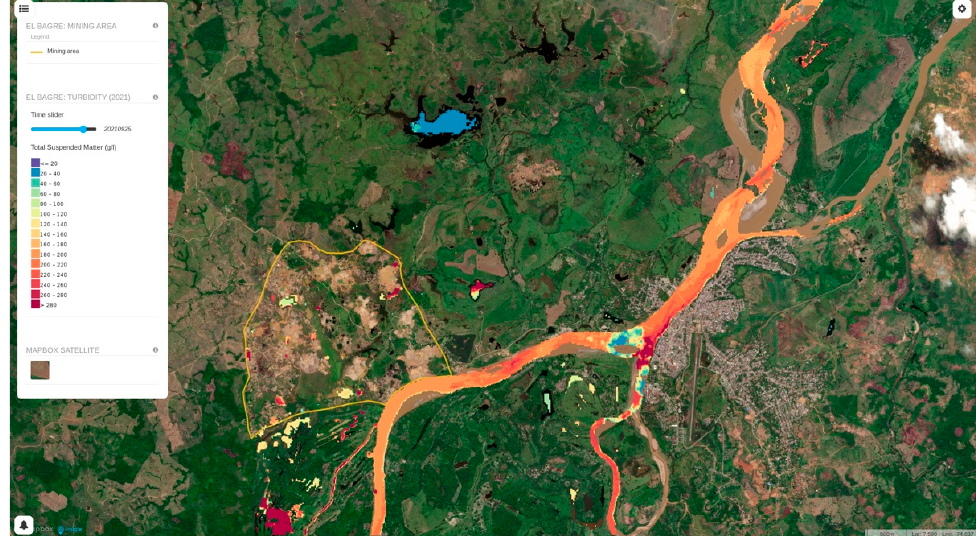
Figure 3. Screenshot of the MapX layer developed for the study area covering the city of El Bagre overlaid on high resolution satellite imagery.